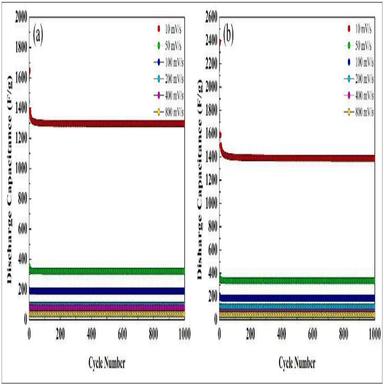
Stable discharge performance during 1000 cycles at different scan rates of NiCeO2 (a), NiCeO2@f-MWCNT/EDA (b).